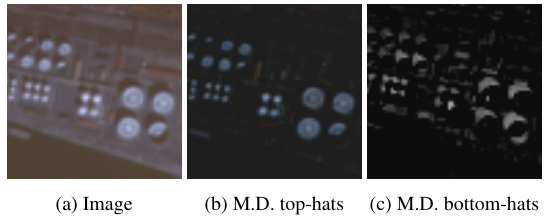
Figure 5. Minimum of directional top-hats vs bottom-hats.